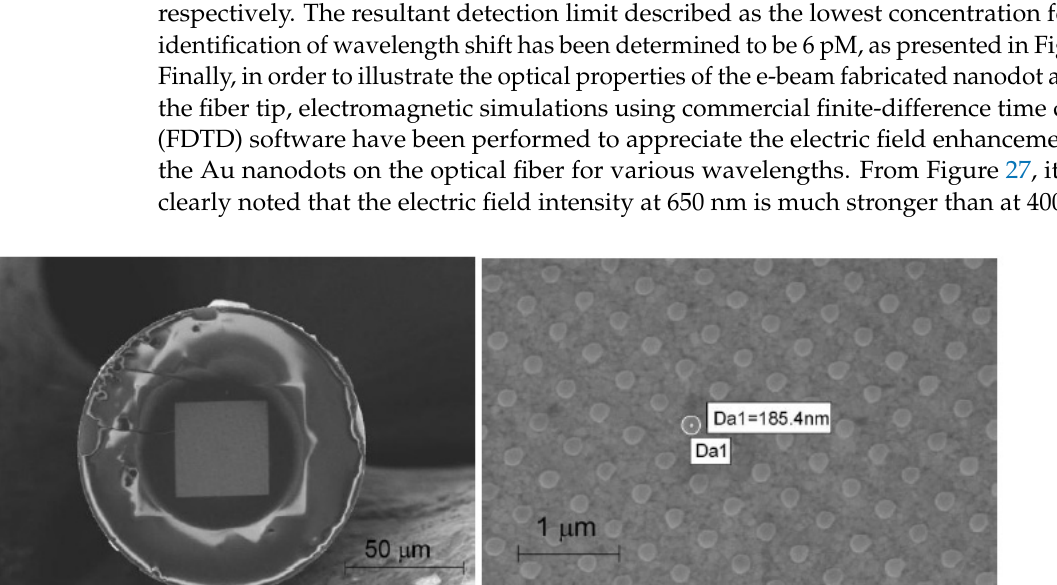
Figure 27. ( a ) The measured and simulated transmission spectra for the nanodot array in air; ( b , c ) intensity of the electric field around the nanodots for 400 nm and 650 nm, respectively. Reprinted with permission of [89].